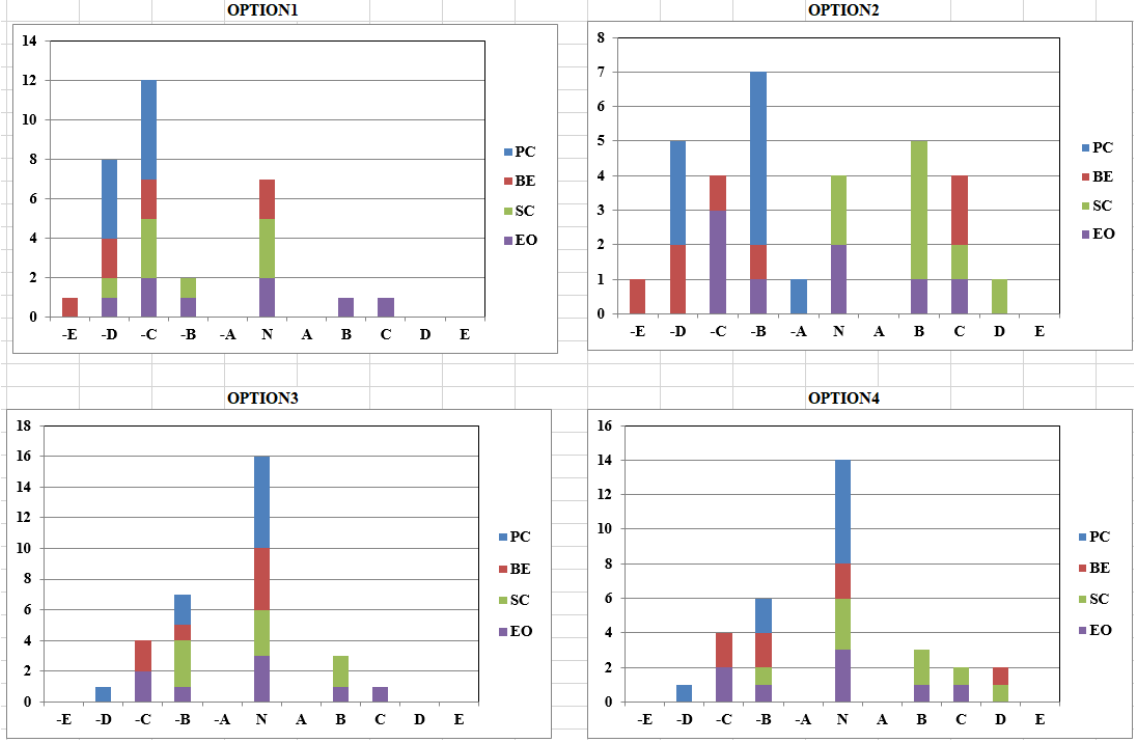
Figure 1 . RIAM analysis for for the evaluated options. PC: Physical/chemical components; BE: Biological/ecological components; SC: Sociological/cultural components; EO: Economical/operational comp-onens